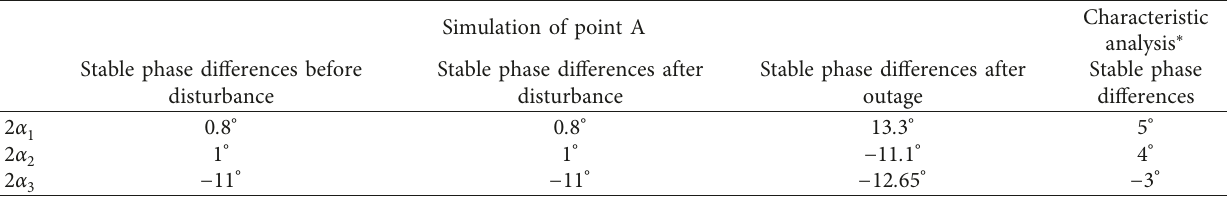
, η . 5. 1 (cid:31) η 2 (cid:31) η 3 (cid:31) 1 4 (cid:31) 0